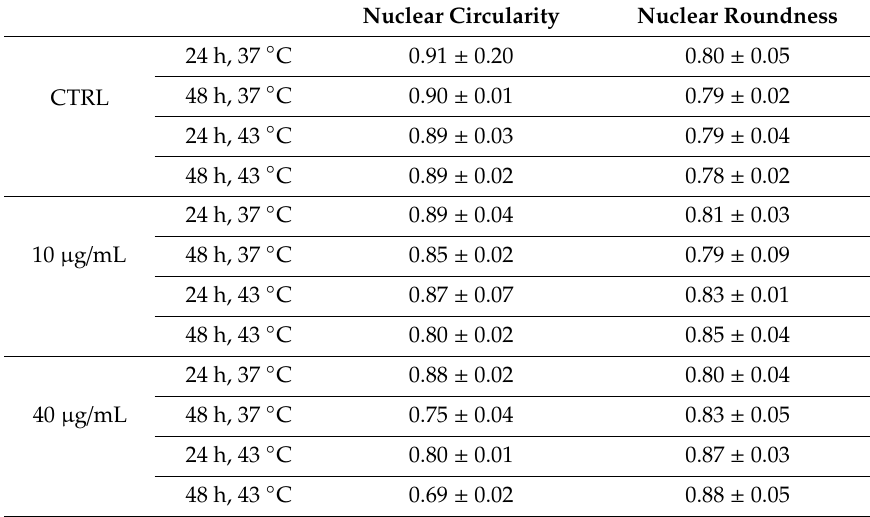
Table 2. Nuclear circularity and nuclear roundness measured by ImageJ software. The control samples were MCF-7 exposed to 37 and 43 ◦ C for 24 h and 48 h without SiO 2 @LA NPs exposure. The treated samples were represented by cells exposed to 10 µ g / mL and 40 µ g / mL for 24 h and 48 h and 37 ◦ C and 43 ◦